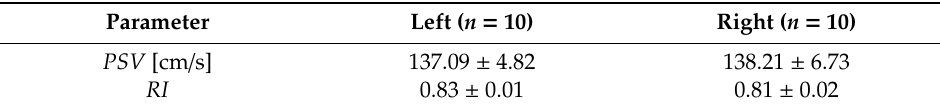
Table 2. The measured peak systolic velocity ( PSV ) and resistive index ( RI ) values (mean ± std) from the left and right common carotid arteries from a volunteer using the developed wireless carotid wearable ultrasound Doppler system